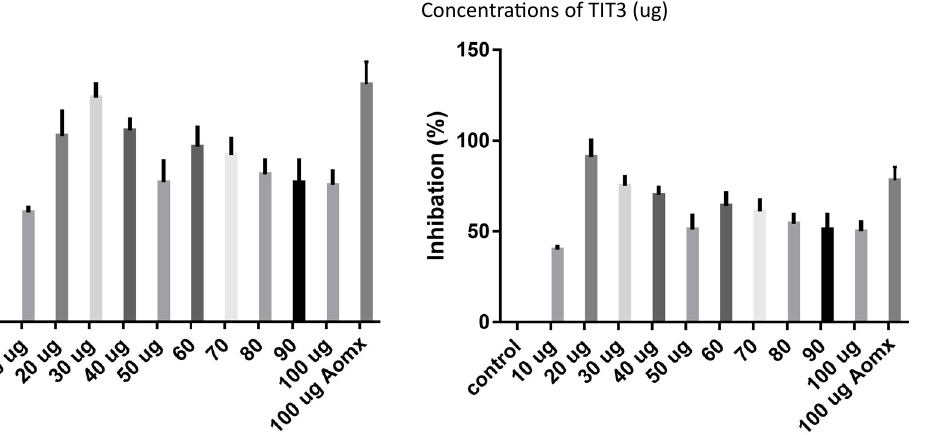
Fig. 4. Inhibation of Escherichia Coli Conentrations of TIT (ug)